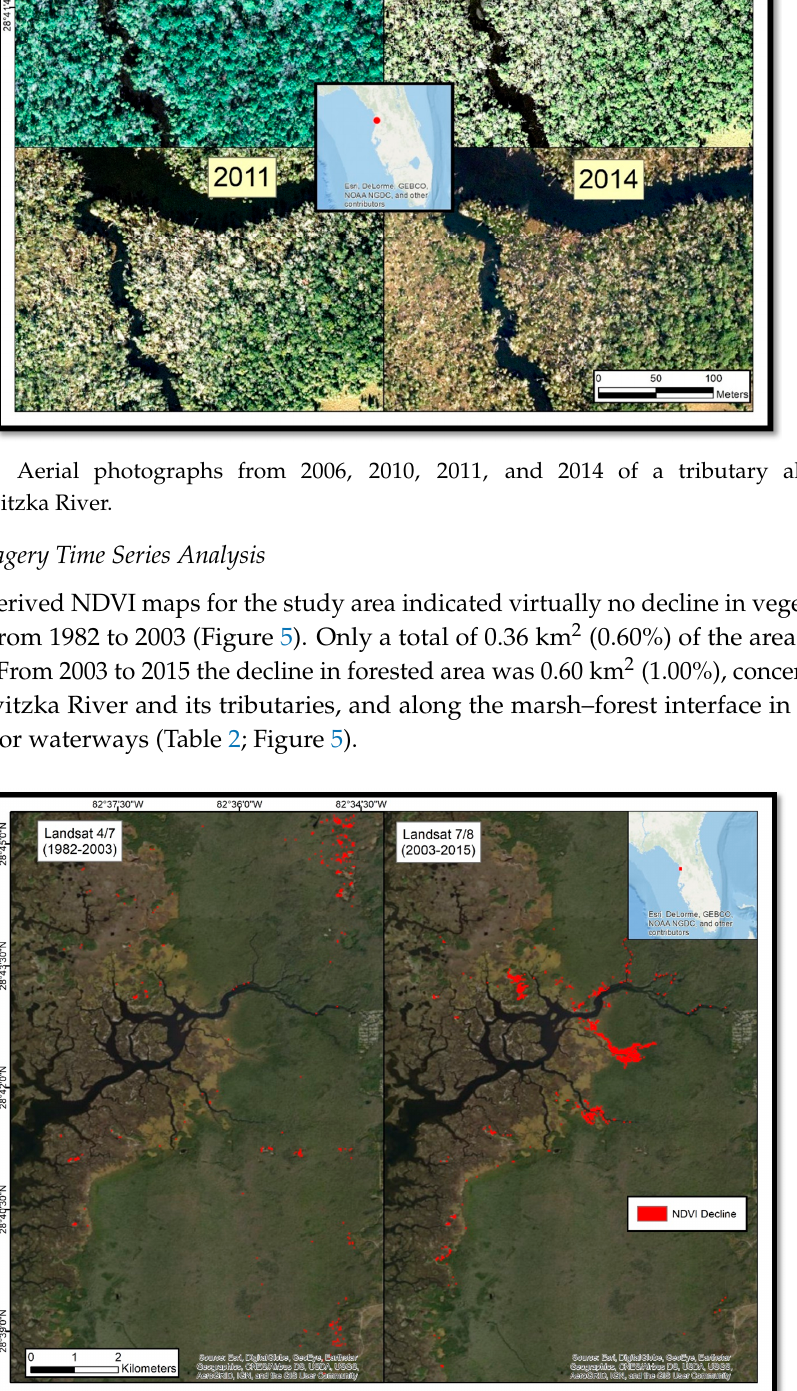
Figure 3. Aerial photographs from 2009, 2010, 2011, and 2014 of a tributary along the Chassahowitzka River appear to show substantial loss of coastal forest adjacent to the waterway.